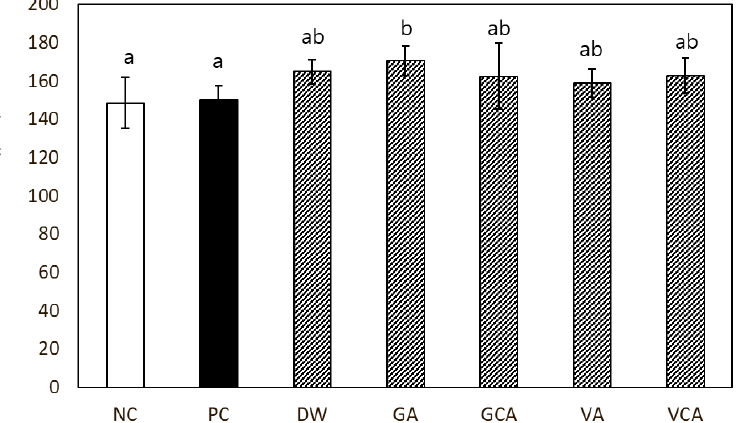
Figure 7. In vivo evaluation of alveolar bone loss in a mouse model. The amount of alveolar bone loss was measured by the distance between the cementum-enamel junction to the alveolar bone crest (CEJ-ABC). Different lowercase letters indicate significant differences among the groups by one-way ANOVA with Tukey’s multiple comparisons ( α ≤ 0.05).